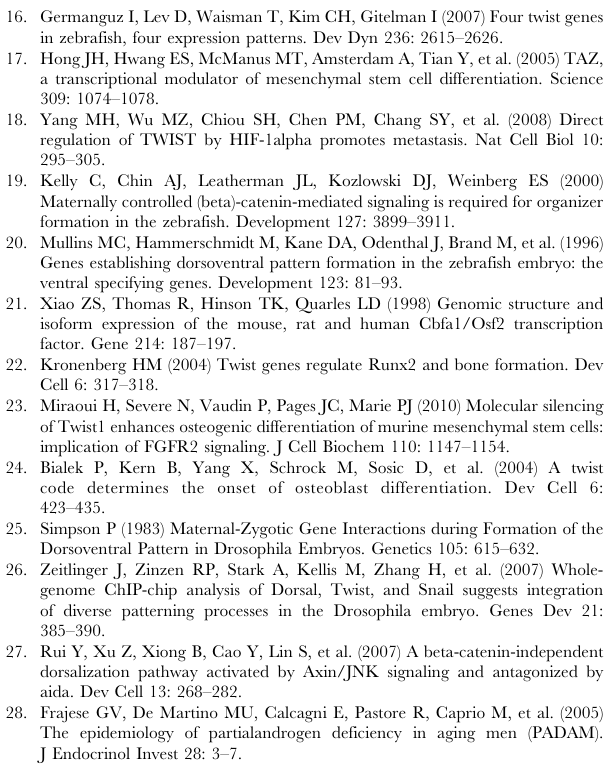
runx2b was performed at 48 hpf (n=3). Results are shown as the relative expression to b -actin (mean 6 SD) and significance was